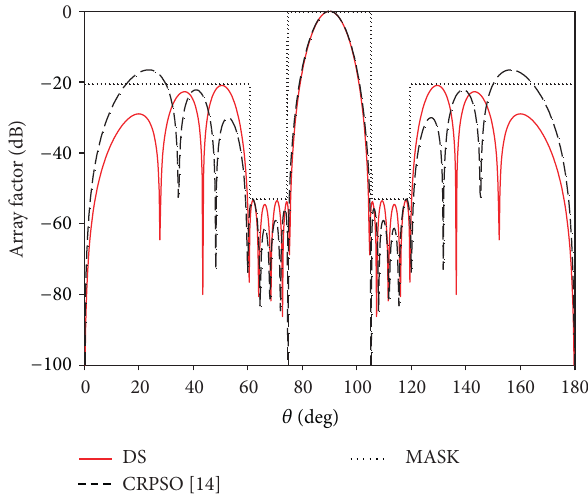
Figure 2: The radiation patterns with wide nulls at [60 ∘ , 75 ∘ ] and [104 ∘ , 120 ∘ ] obtained by DS and CRPSO [14] for the second example (16